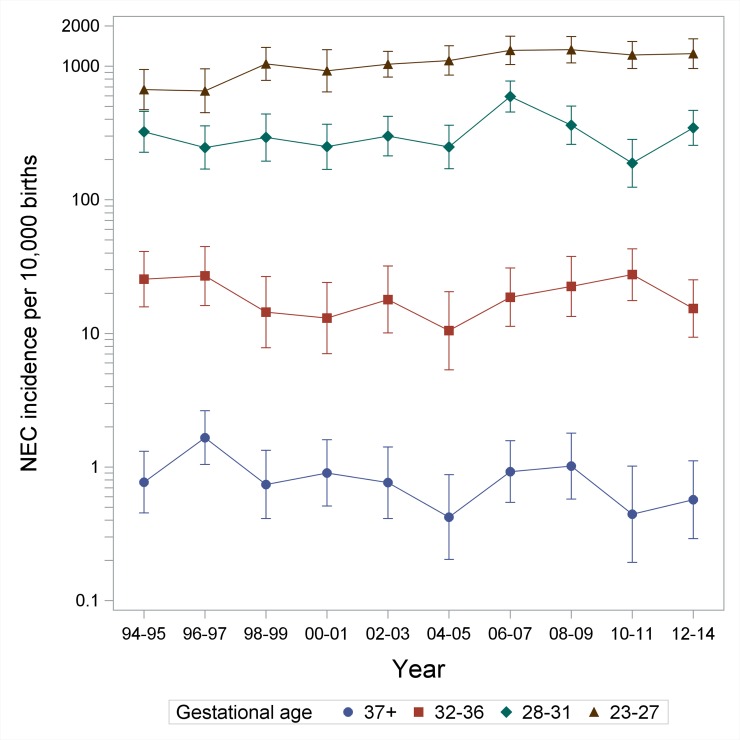
Number of NEC cases per 10,000 children born according to year of birth, divided into four gestational age groups.Please note, that the y-axis is logarithmic.